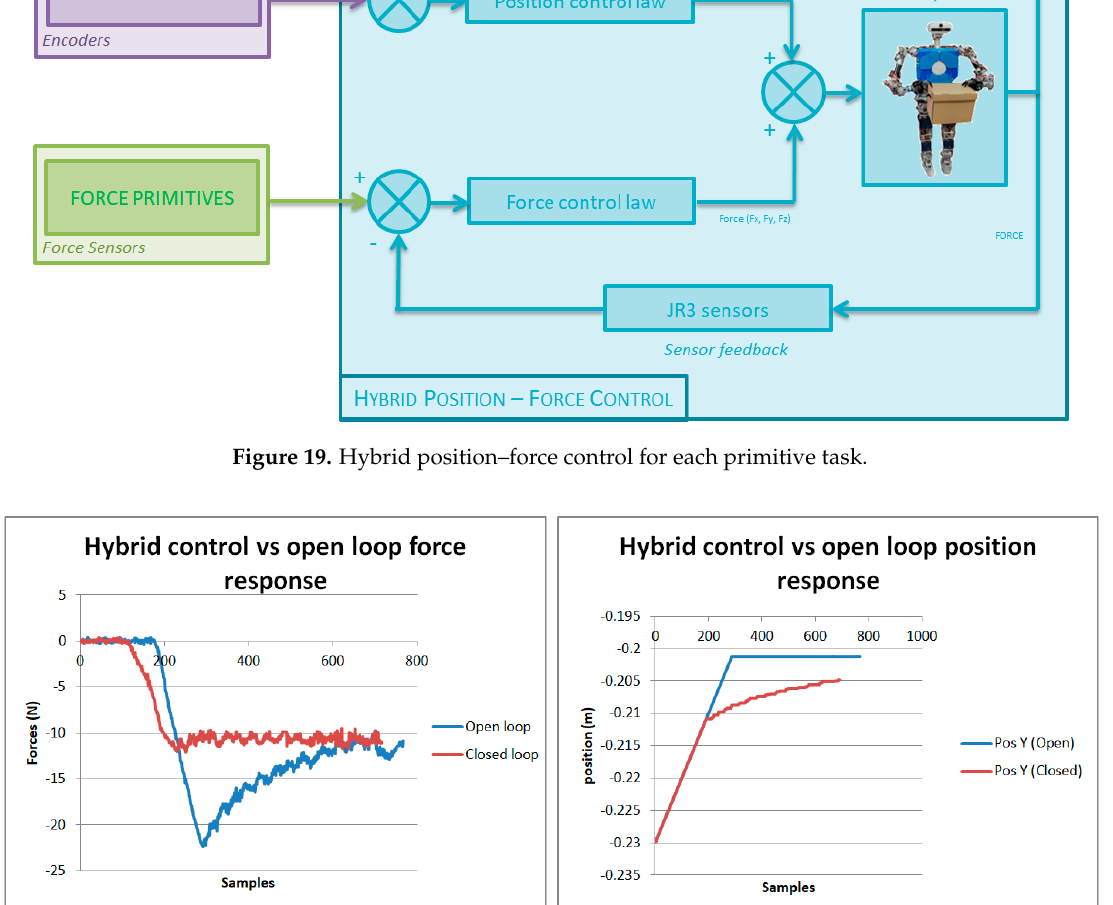
Figure 20. Hybrid position–force control for lifting primitive task. ( a ) Comparison of the required force to lift a box in open and closed loop. ( b ) Comparison of the end effector position to lift a box in open and closed